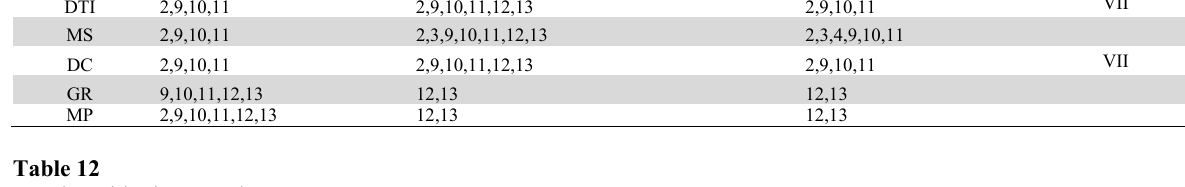
Level partitioning Iteration 8 Enabler